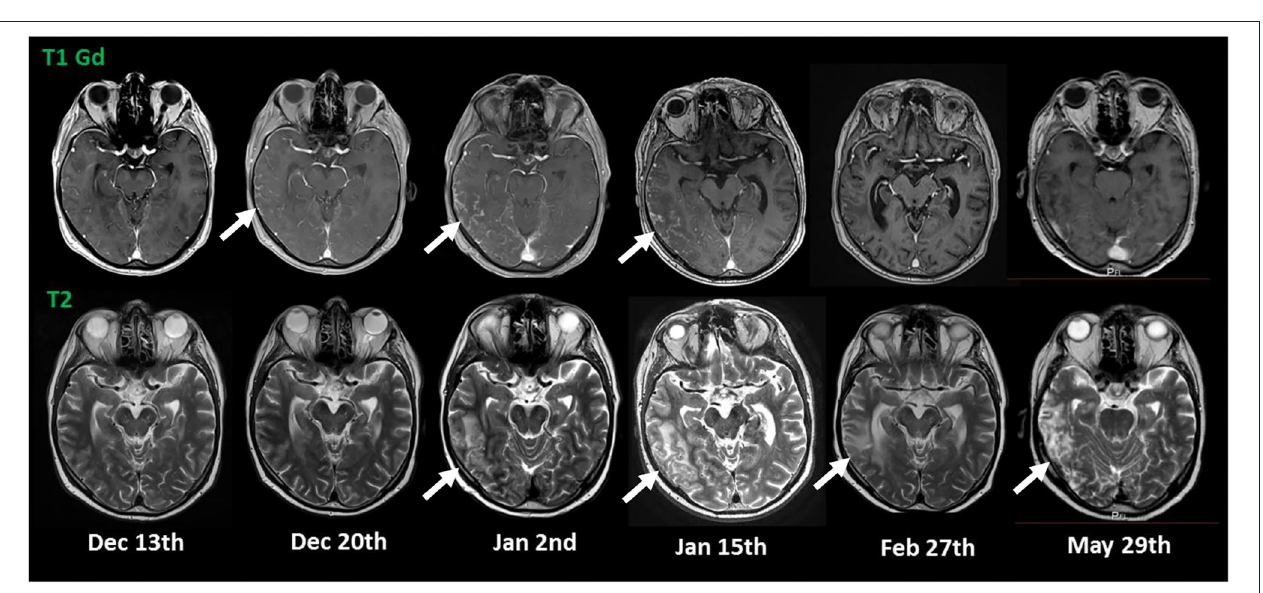
a Th1 mediator, in T-cells (11). Monoclonal TNF- α